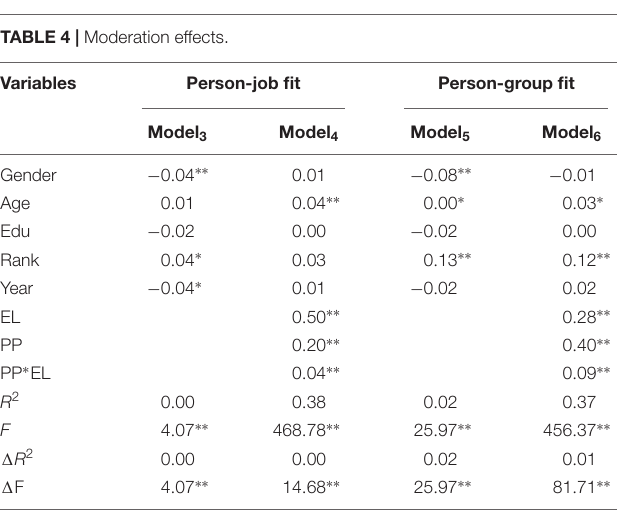
TABLE 4 | Moderation effects.